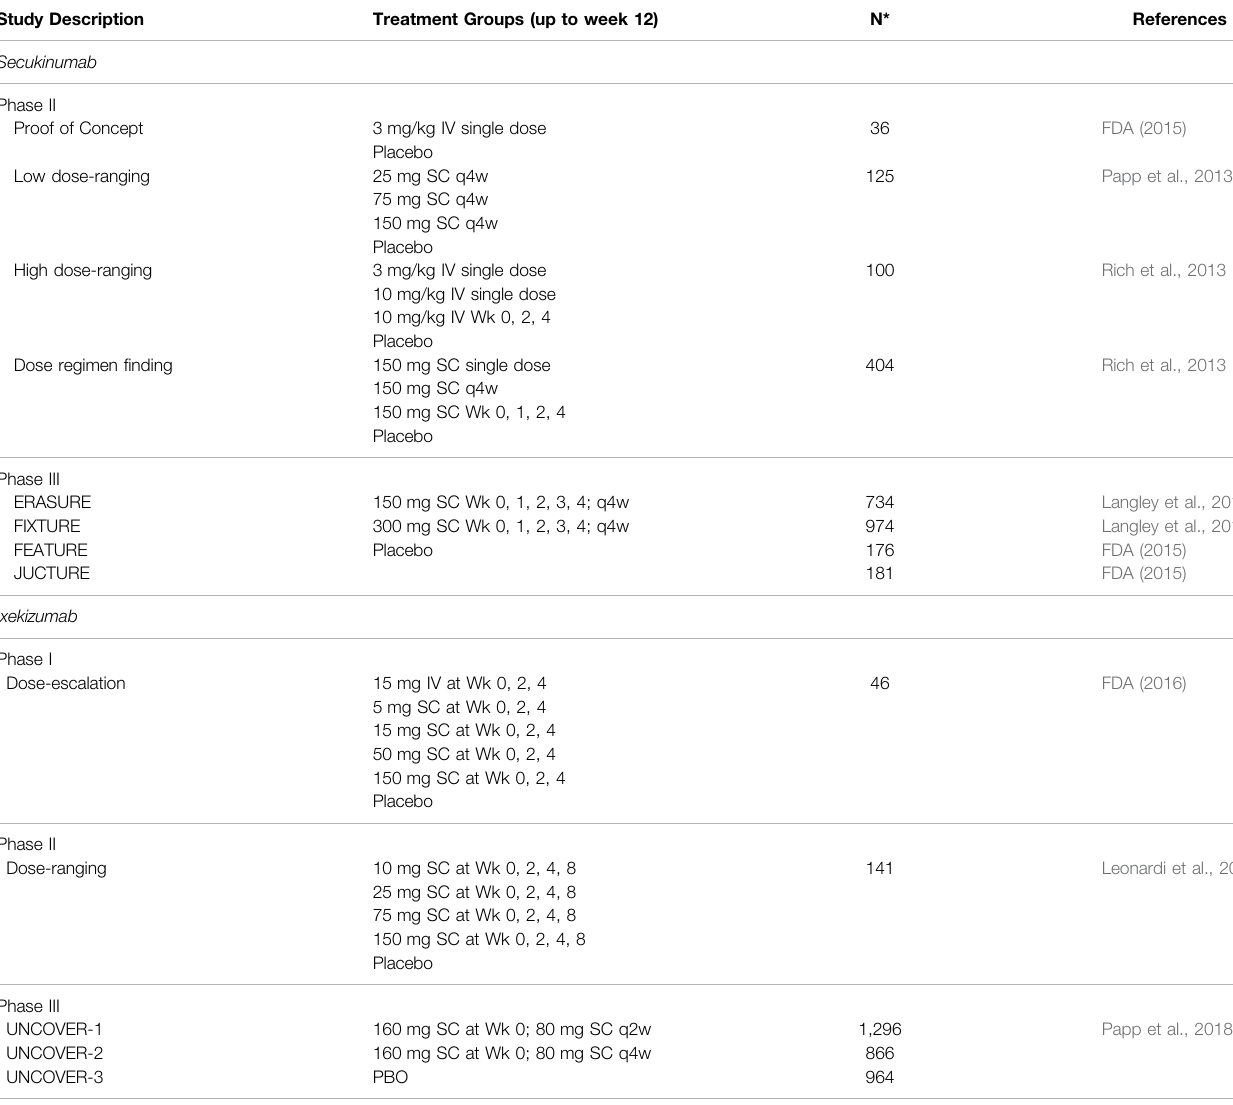
TABLE 1 | Randomized placebo-controlled clinical trials of secukinumab and ixekizumab in psoriasis patients included in the analyses. Study